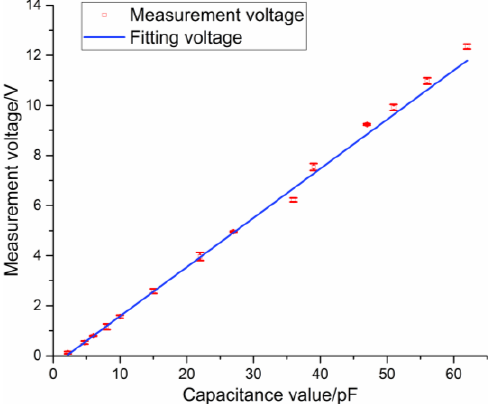
Sensors 2016 , 16 , 699 10 of 16